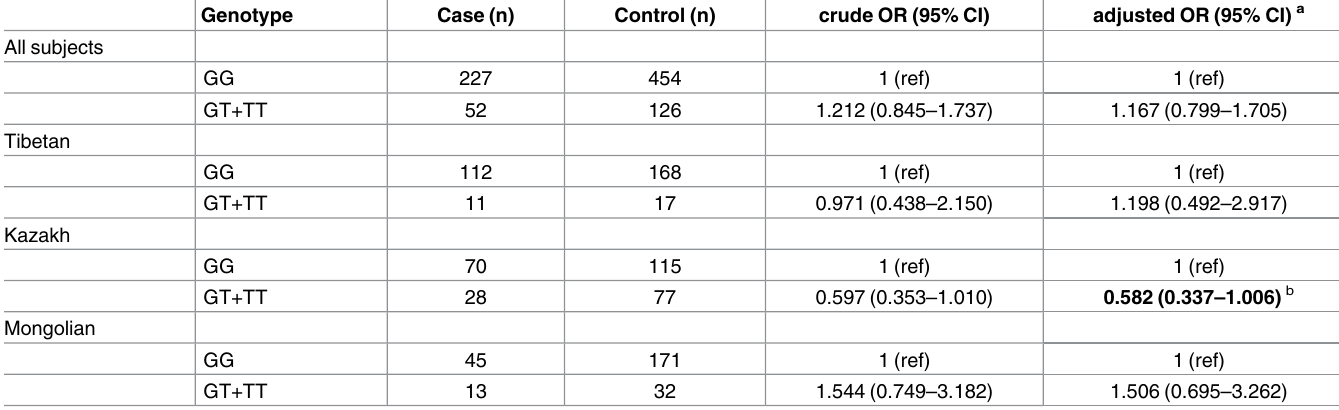
Table 3. Associations between skeletal fluorosis and the PRL rs1341239 genotype (overall or stratified by ethnicity).